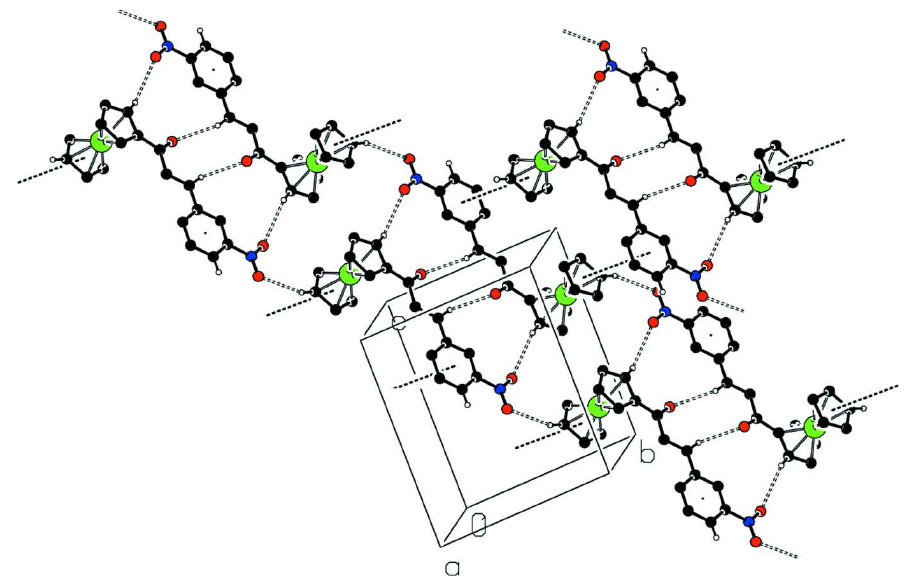
Part of the crystal structure of the title compound, showing the formation of a hydrogen bonded R 44 (16) chain via C— H···O and pi (aryl ring)···pi (Cps ring) inter-molecular hydrogen bonds (dashed lines) along c axis,. For the sake of clarity, H atoms not involved in hydrogen bonding have been